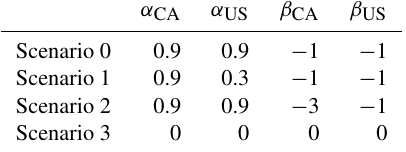
Table 3. The configuration of different other-regarding preferences of Canada and the United States for scenario analysis. In Scenario 0, both countries have the same level of inequality aversion, while in Scenario 1, the United States has less guilt than Scenario 0, in Sce- nario 2, Canada is more jealous than in Scenario 0, and in Sce- nario 3, both countries are only concerned with their own utility. α CA α US β CA β